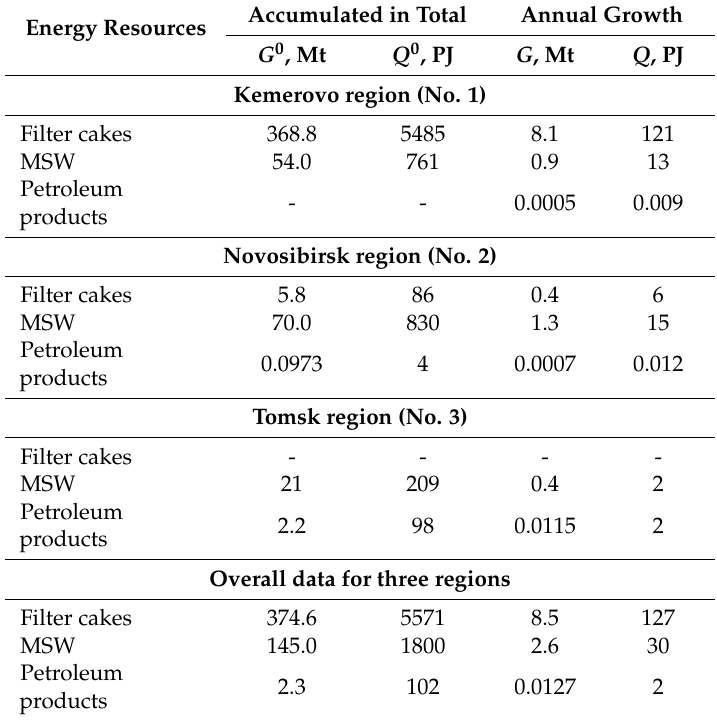
Table 7. Energy potential of each region due to accumulated and annually produced waste. Energy